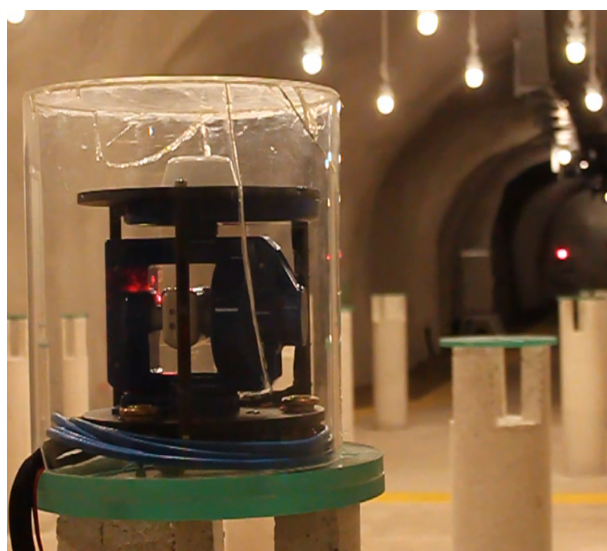
Figure 6. AutoDIF mk2.2 with its Plexiglas cloche on pillar A16 in the tunnel of Conrad observatory